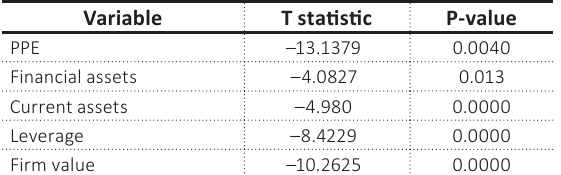
Table 2. Stationarity test results